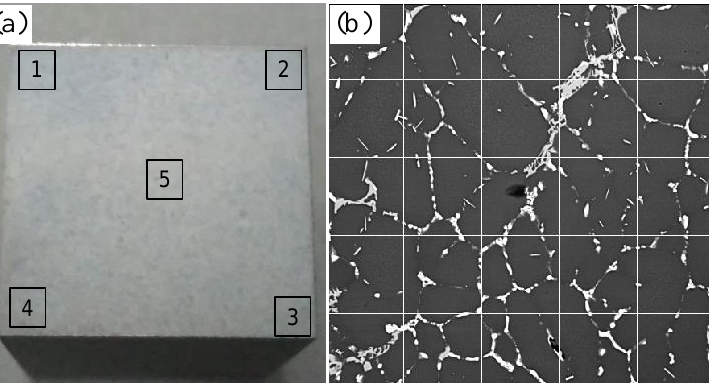
Figure 3. Measurement of the eutectic phase by the cross-section method and the linear intercept method. ( a ) Schematic diagram of selected areas; ( b ) schematic diagram of division of the linear intercept method of backscatter image.